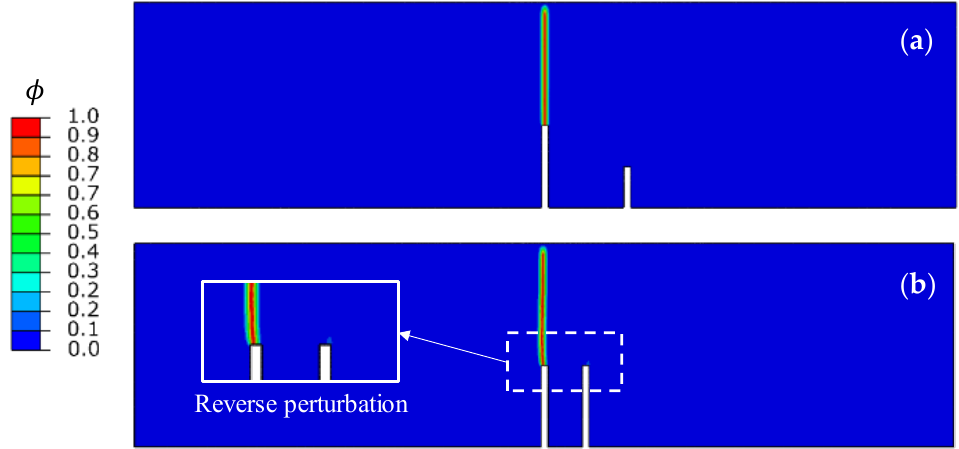
Figure 11. A concrete specimen: geometry, loading and boundary conditions.